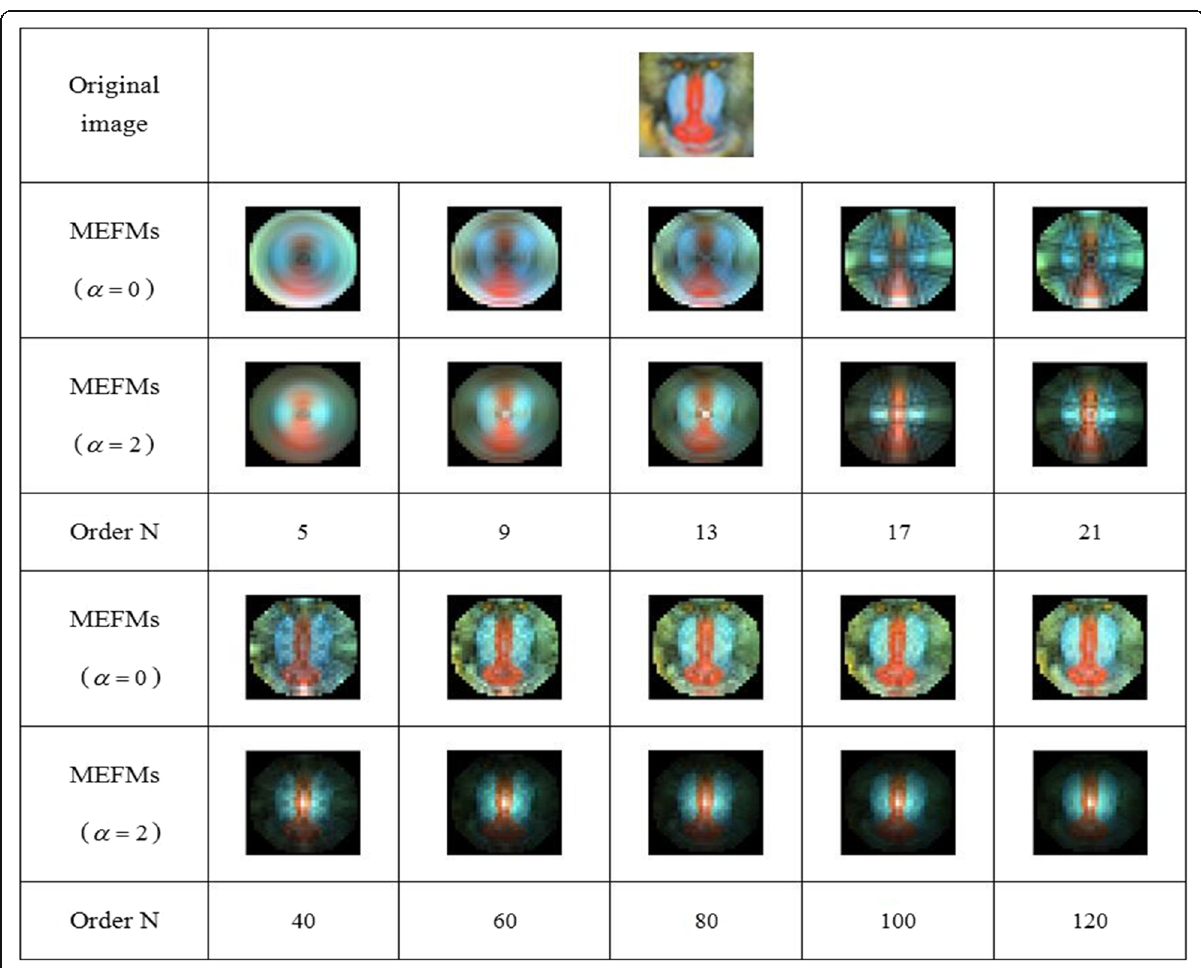
Fig. 10 Color image baboon are reconstructed in parameters ( α = 0 and α = 2) under different order